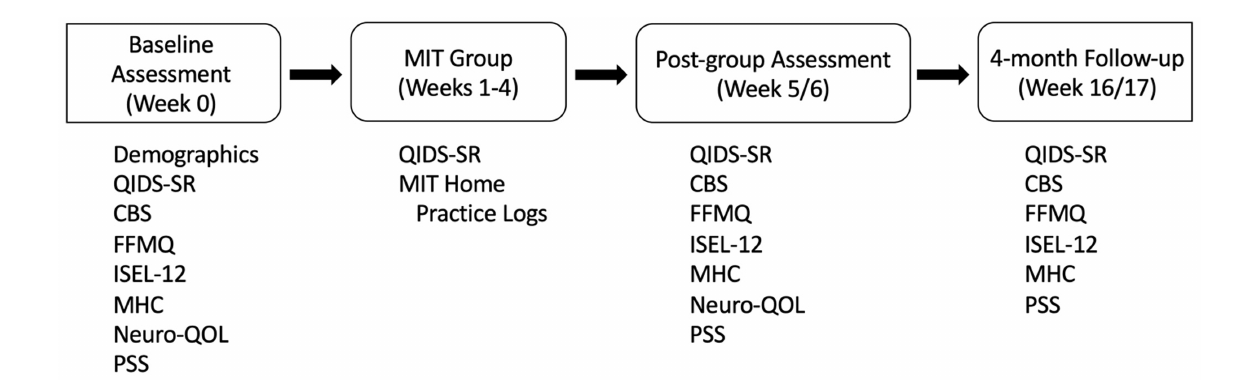
FIGURE 1 Trial flow. CBS = Caregiver Burden Scale, FFMQ = Five Facet Mindfulness Questionnaire, ISEL-12 = Interpersonal Support Evaluation List 12 item, MIT = Mentalizing Imagery Therapy, MHC = Mental Health Continuum – Short Form, Neuro-QOL = Neurological Quality of Life, PSS = Perceived Stress Scale, QIDS-SR = Quick Inventory of Depressive Symptoms – Self